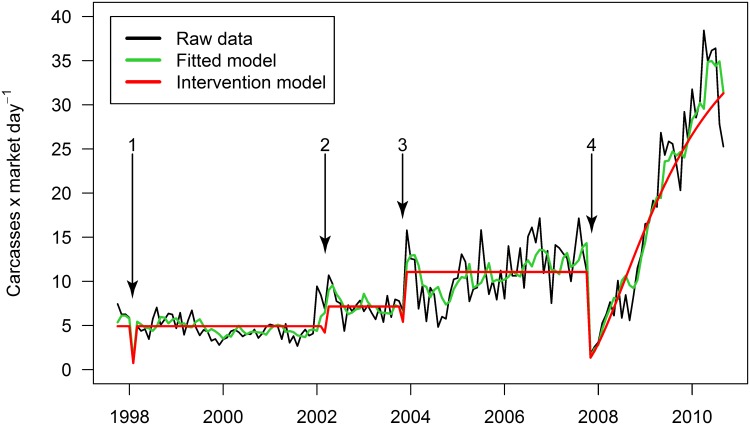
Primate carcass rates raw data, fitted, and predicted values.Values are as estimated in the intervention analysis via ARIMA (2,0,0,)x(1,0,0)12. Significant interventions are numbered at: 1) 2/1998 –political uprising; 2) 3/2002 –bushmeat roundtable; 3) 11/2003 –Law 7/2003; 4) 11/2007 –Decree 72/2007.